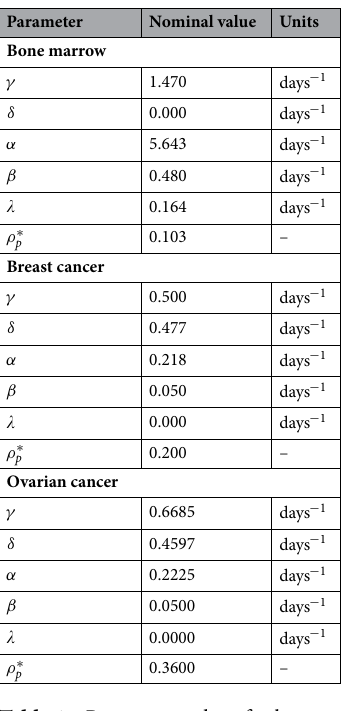
Table 1. Parameter values for breast cancer cells, ovarian cancer cells, and bone marrow cells as obtained from Refs. 1,10 , and values of ρ ∗ p as determined by Eq.